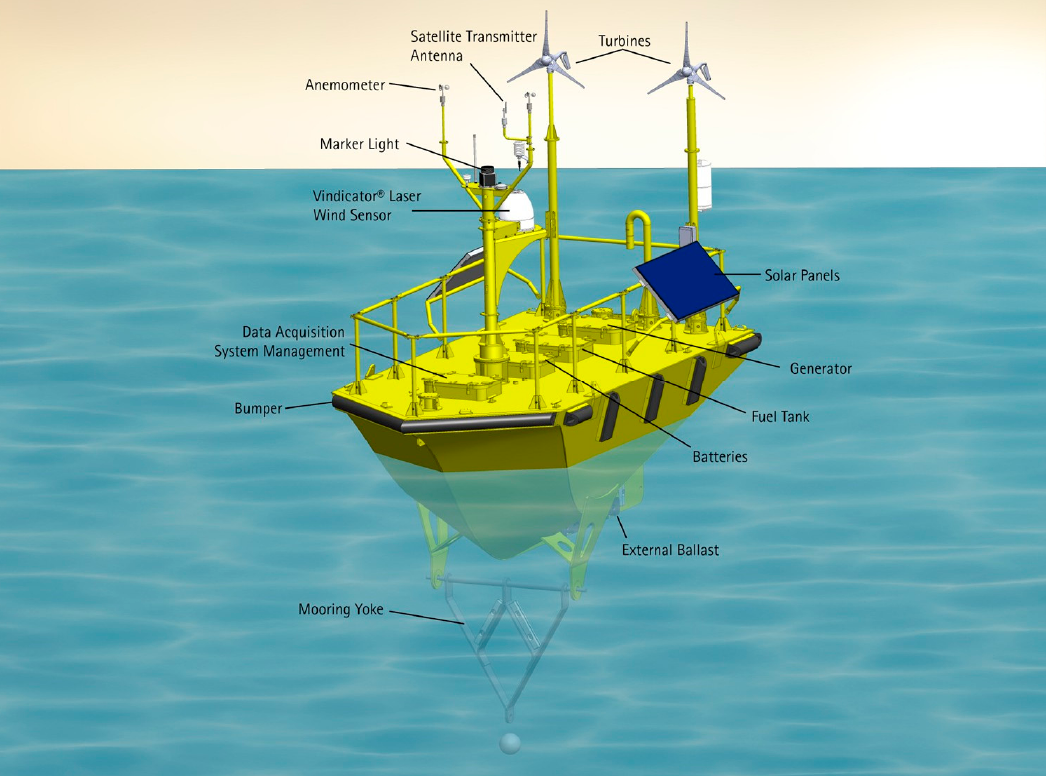
Figure 4. The AXYS FLiDAR 6M meteorological buoy [22].